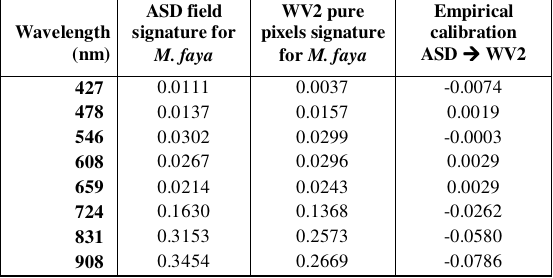
Table 1. Empirical calibration parameters resulting from the comparison between M. faya field and WV2 image samples.